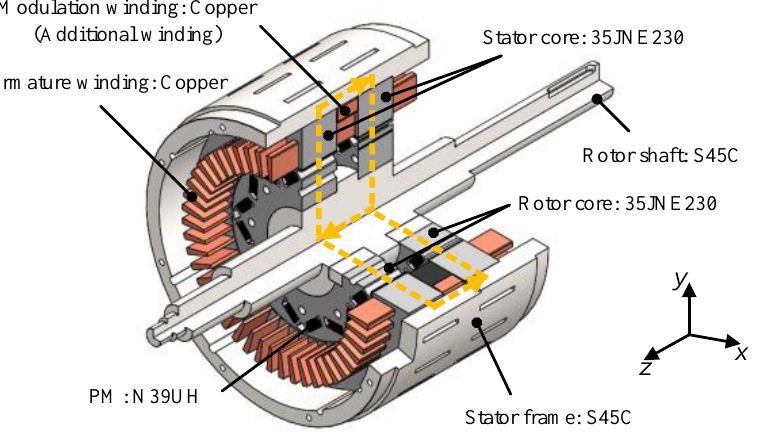
Figure 2. Magnetic circuit of prototype motor. Table 1. Specifications of prototype motor.